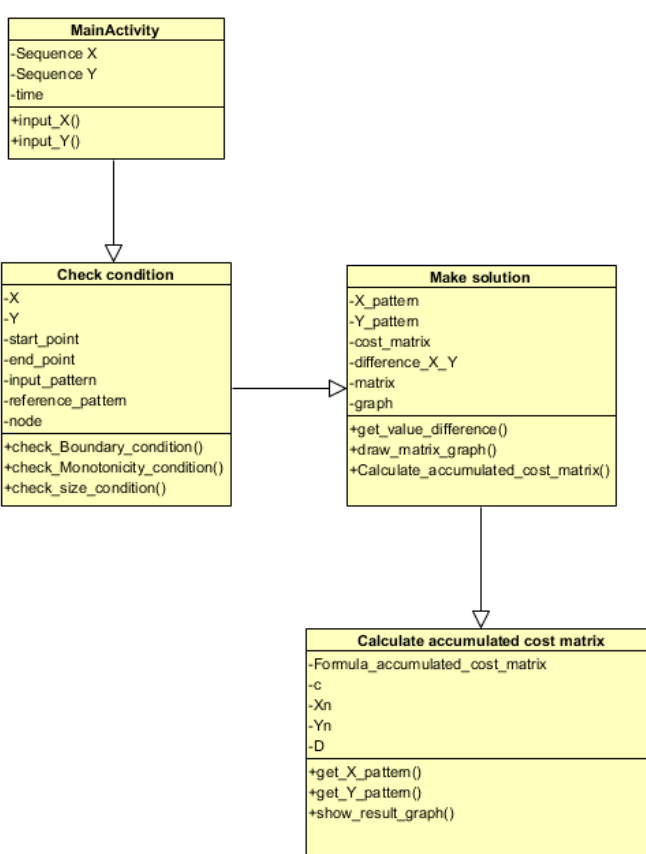
Figure 6. The UML of the surgery agreement signature authentication system.